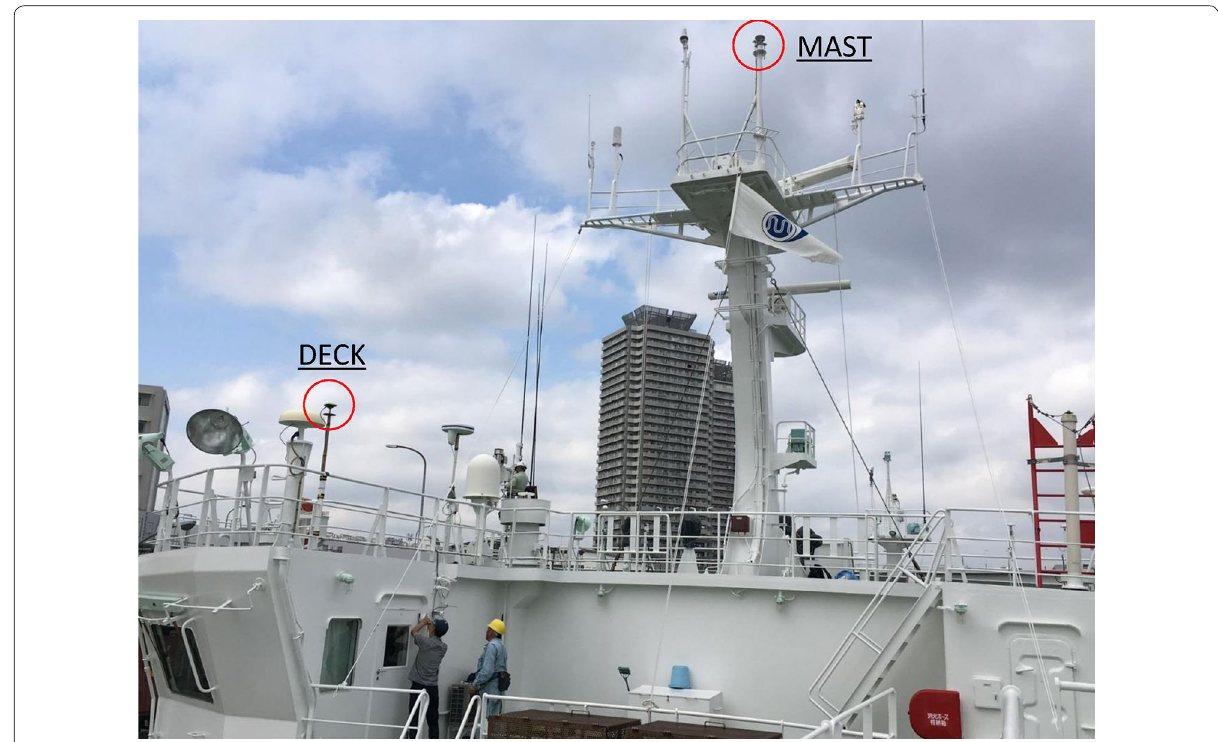
Fig. 1 GNSS antennas installed on the top deck (DECK) and on the mast (MAST) of the RYOFU MARU on October 19, 2017. The MAST antenna was moved to the DECK location on June 19, 2017, and was used for additional observations as DECKt until August 6,